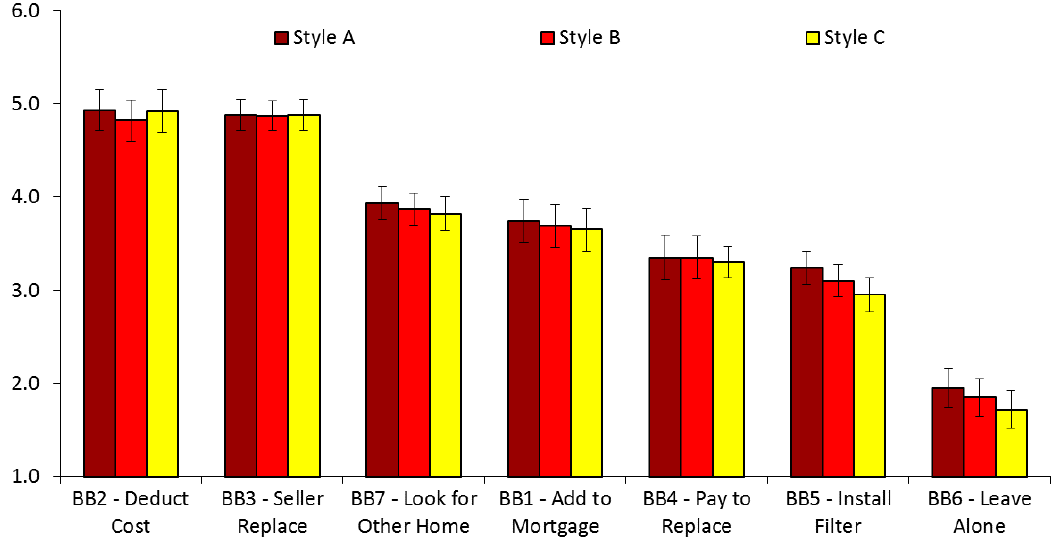
Figure 3. Willingness to adopt risk mitigation behaviors, by seller/buyer condition. Error bars indicate 95% confidence intervals, with Bonferroni corrections.